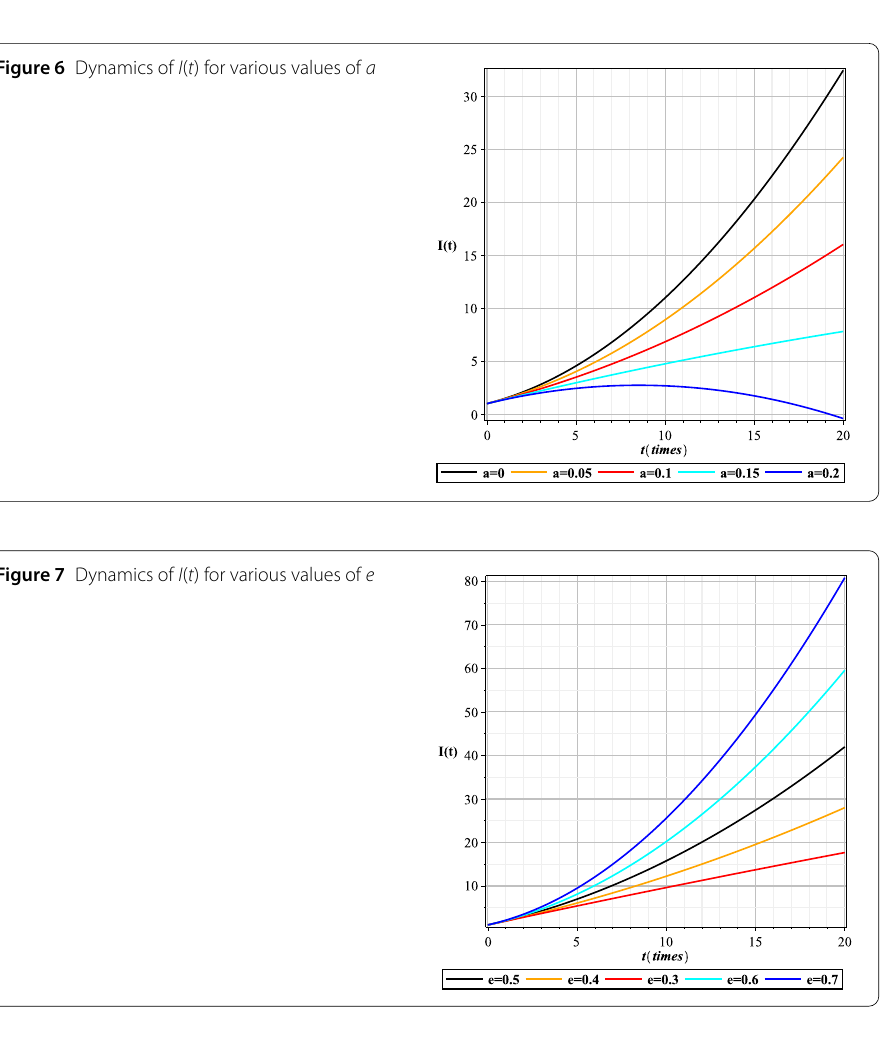
Figure 6 Dynamics of I ( t ) for various values of a